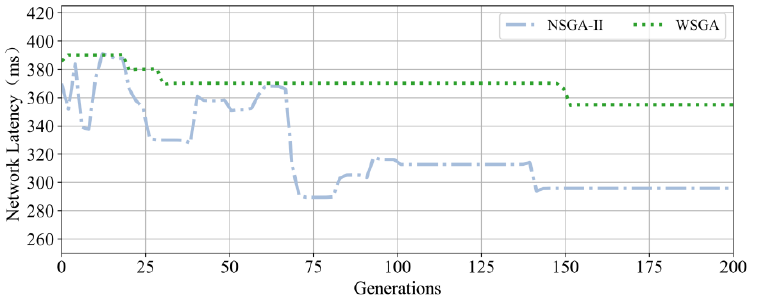
Figure 9 . Comparison of network